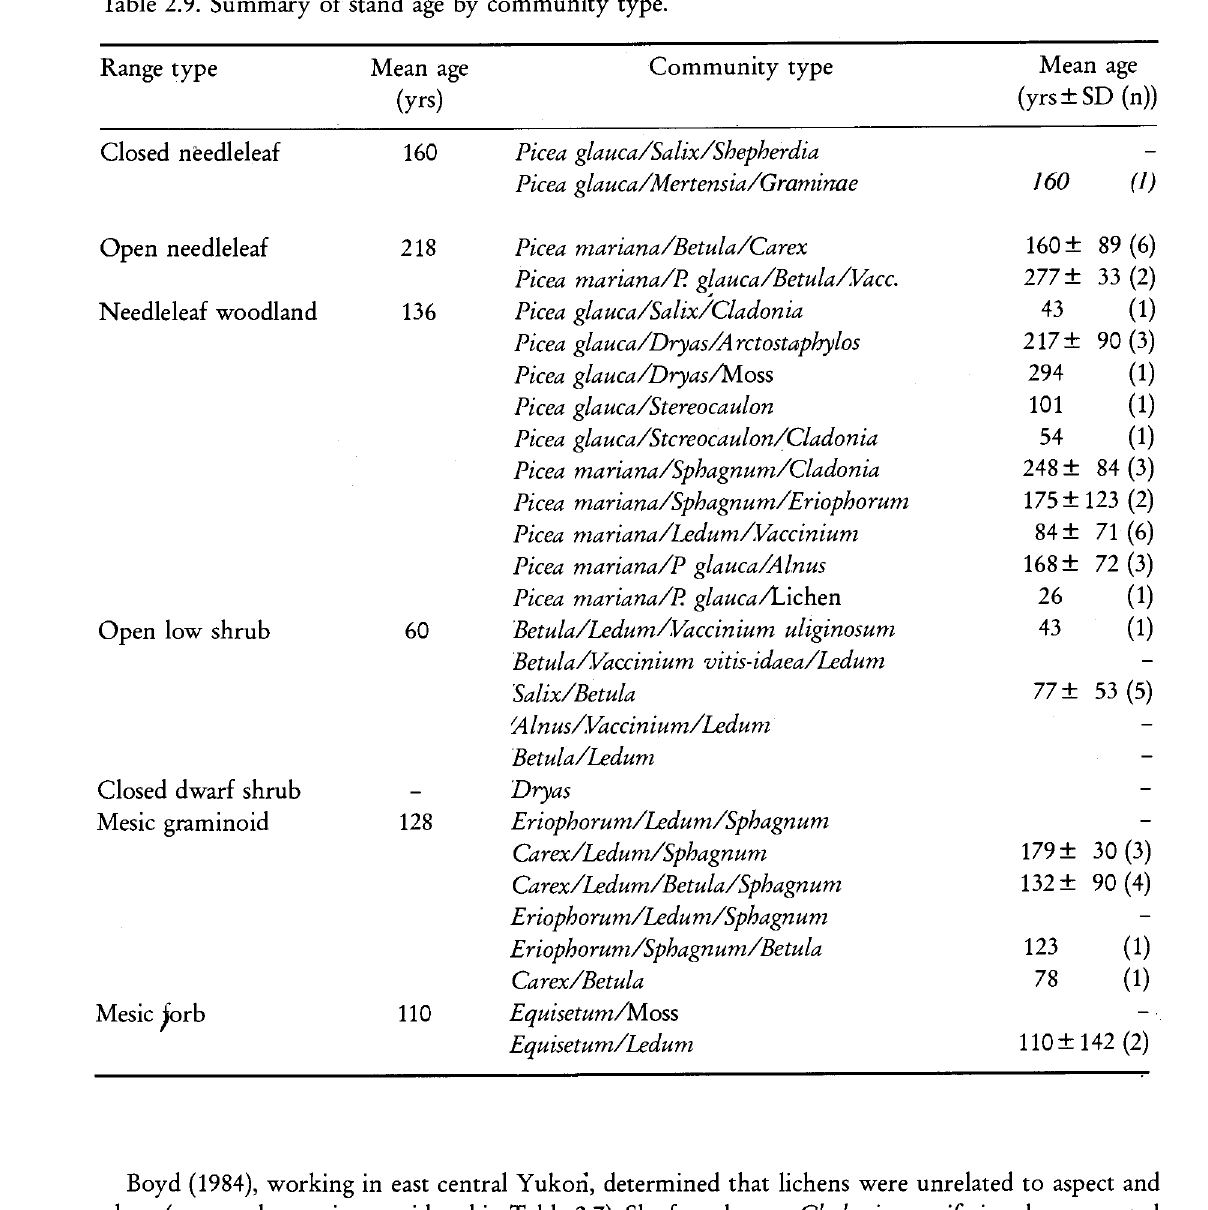
Table 2.9. Summary of stand age by community